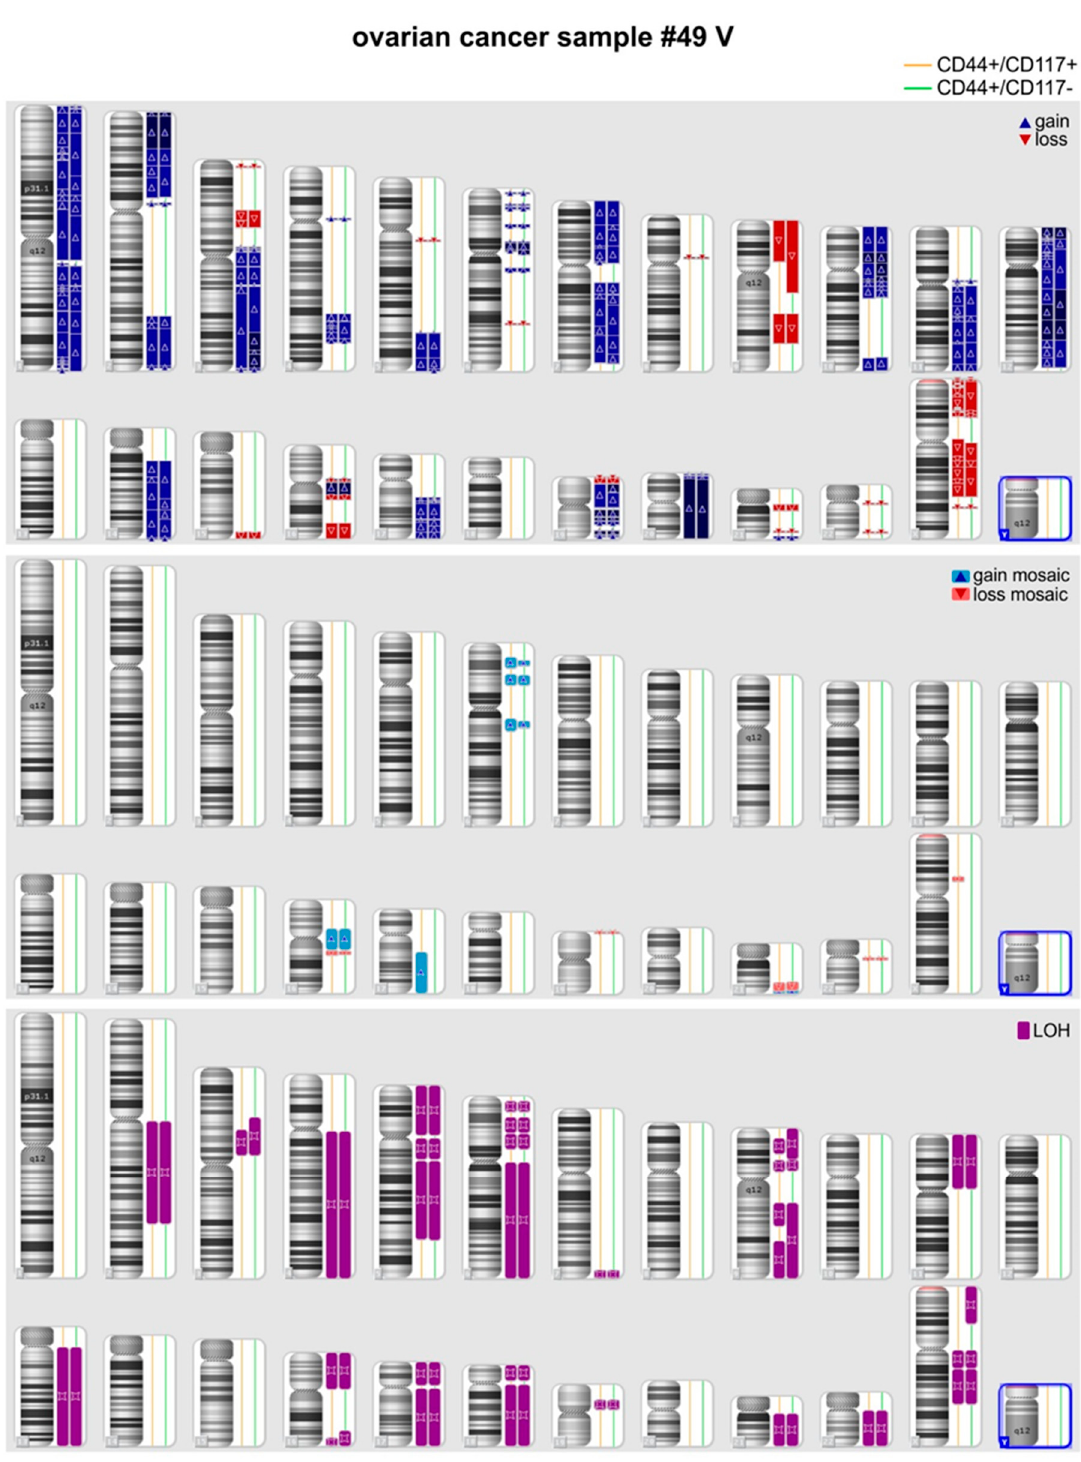
Figure 2. Comparison of chromosomal alterations in CSCs versus non-CSCs by Cytoscan SNP-array in one representative ovarian cancer patient (#49 V).